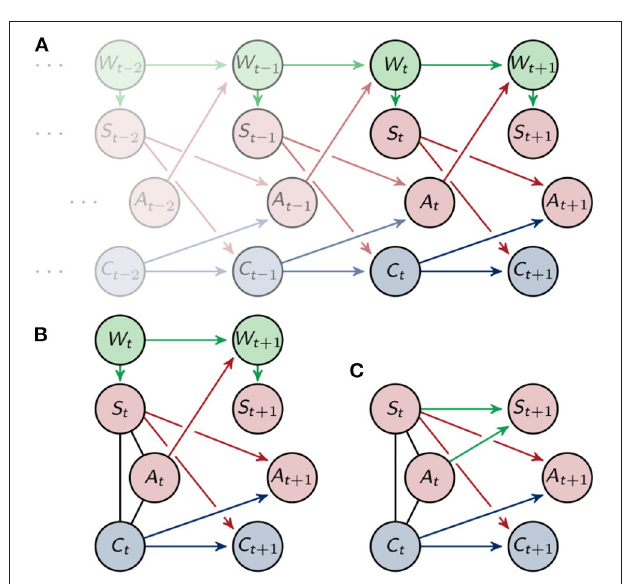
relationship between graphs and graphical models. Throughout